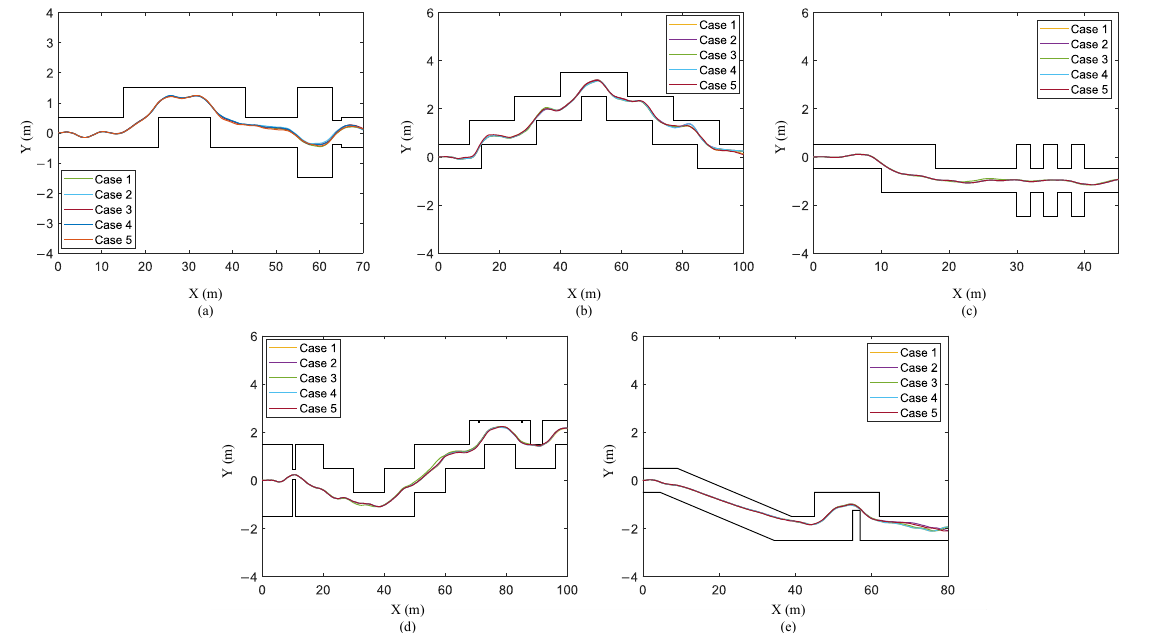
Figure 14. Trajectories of the STTW robot in test scenario III: ( a ) training terrain; ( b ) test terrain 1; ( c ) test terrain 2; ( d ) test terrain 3; ( e ) test terrain 4.